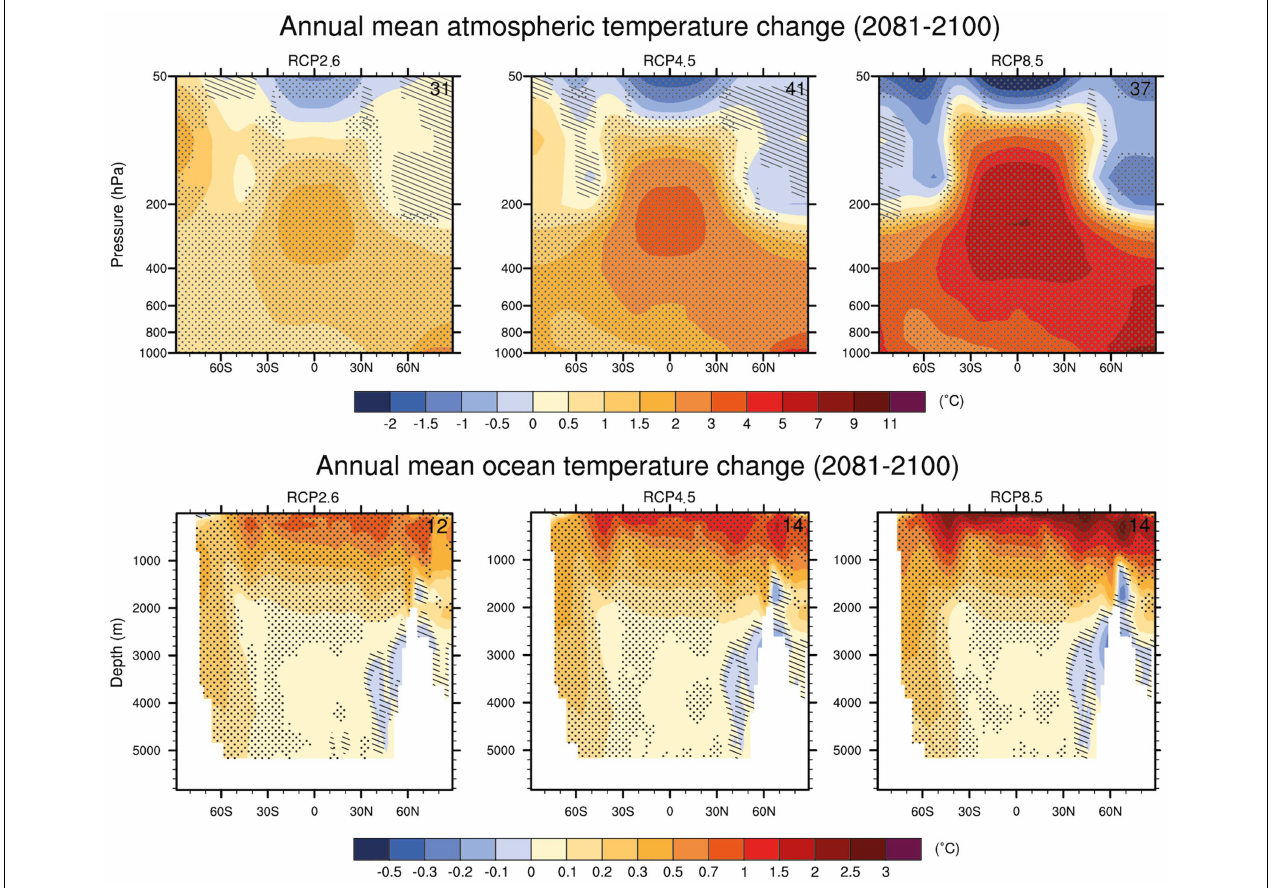
FIGURE 3 | CMIP5 multi-model changes in annual mean zonal mean temperature in the atmosphere and ocean relative to 1986–2005 for 2081–2100 under the RCP2.6 (left), RCP4.5 (center) and RCP8.5 (right) forcing scenarios. Hatching indicates regions where the multi model mean